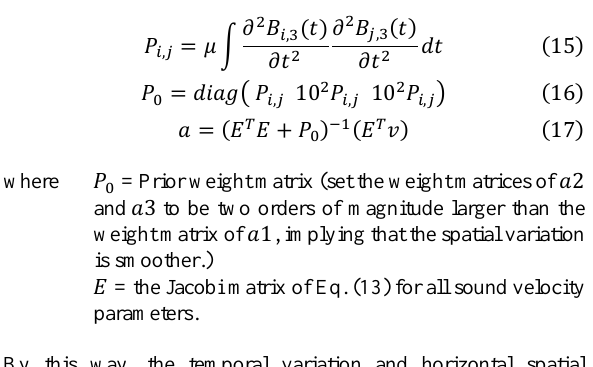
Table 1 . Positioning results of simulation data.